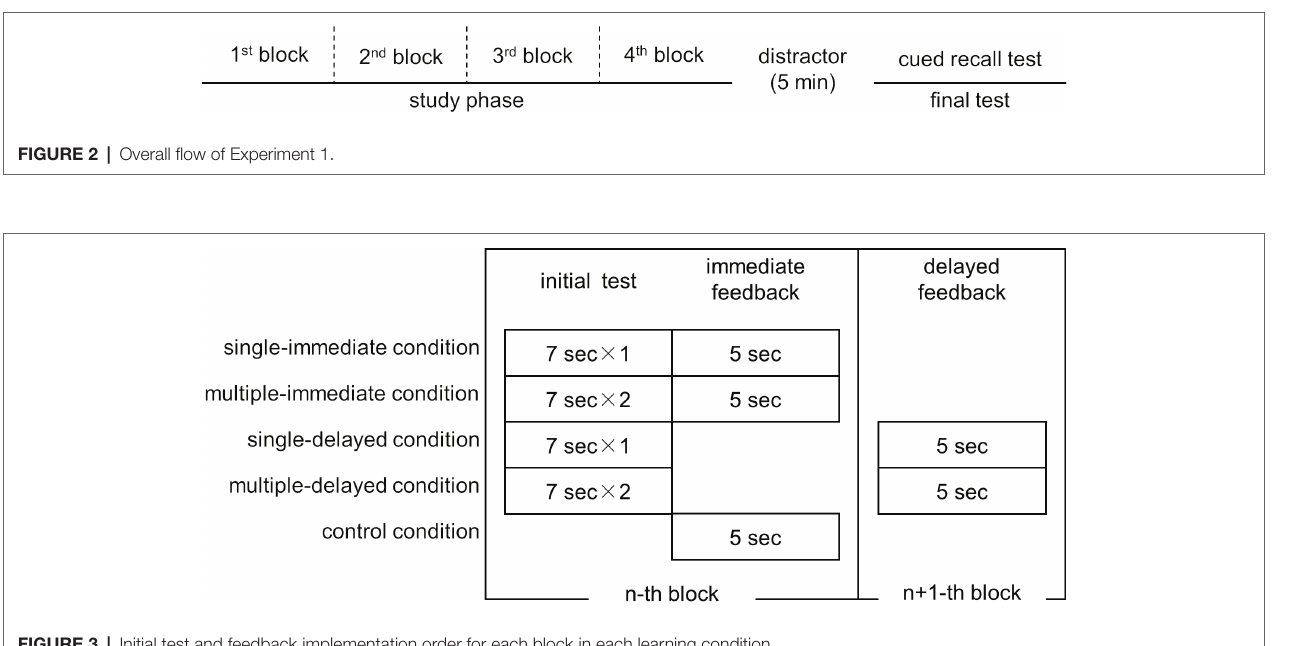
FIGURE 3 | Initial test and feedback implementation order for each block in each learning